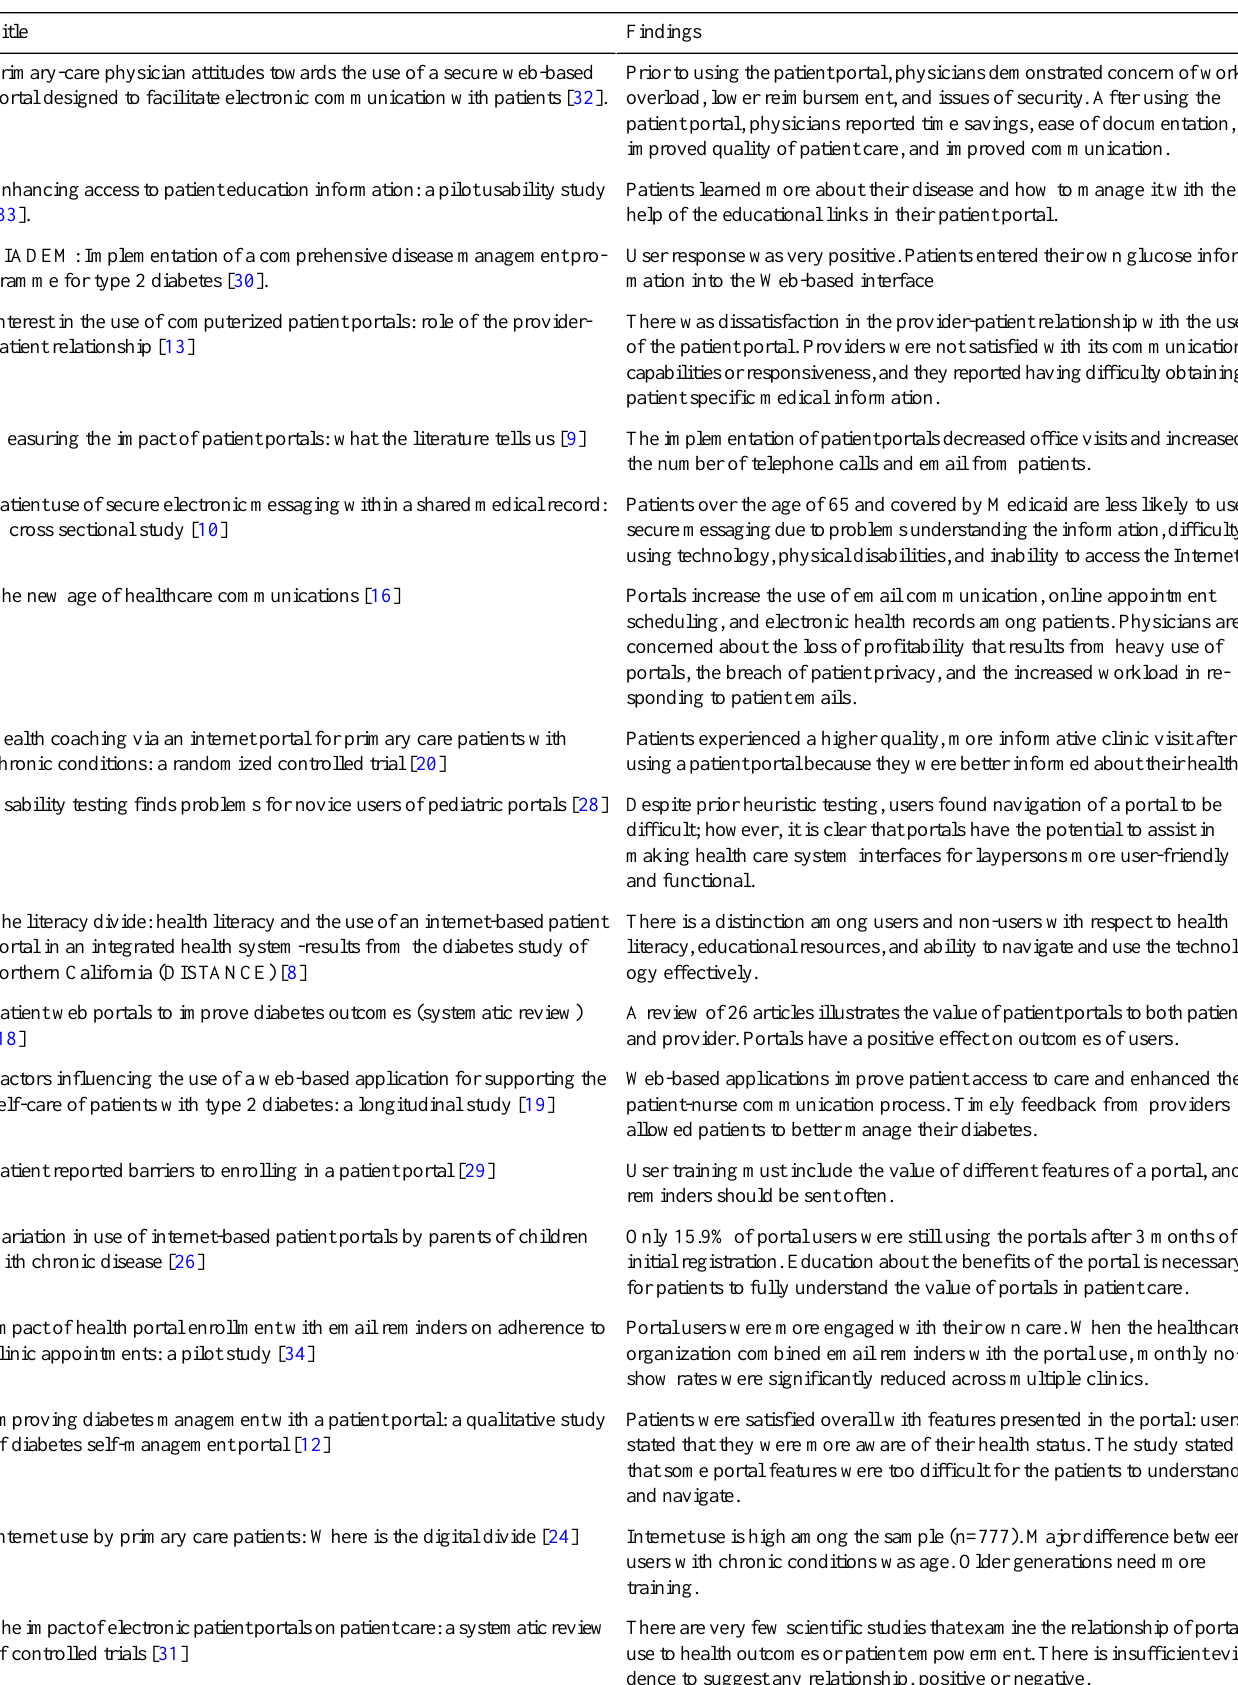
Table 1. Summarized findings of the literature.